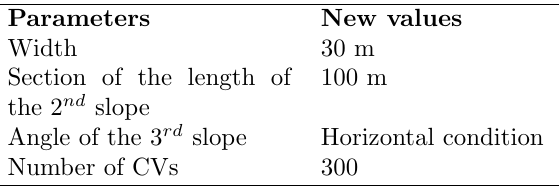
Table 4: Modified quantities